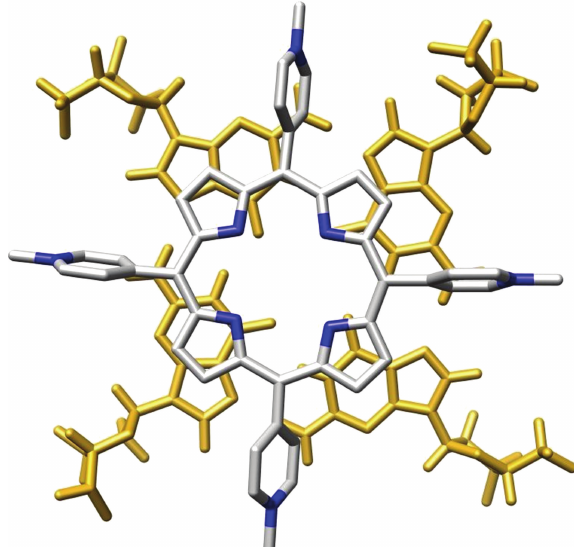
Figure 5: Qualitative in silico superposition of HXDV and a G- tetrad (extracted from PDB entry: 2A5R); guanine residues appear in gold, the carbon, nitrogen, oxygen, and hydrogen atoms of HXDV in grey, blue, red and white, respectively.